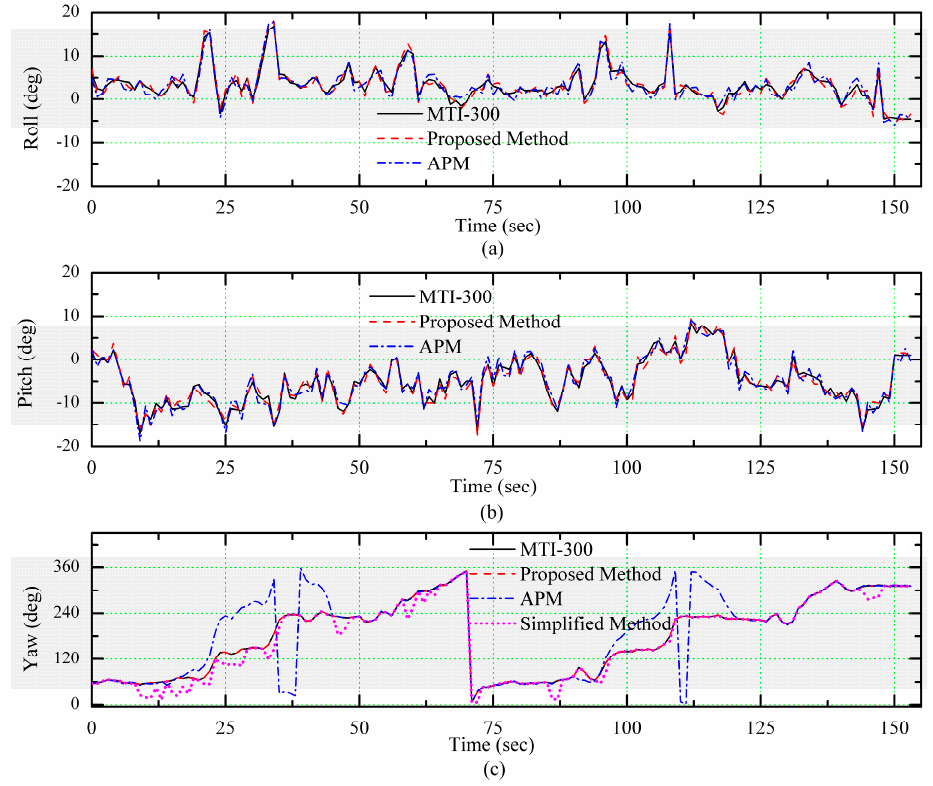
Figure 8. The estimated attitude over time. ( a ) Roll, ( b ) Pitch, ( c ) Yaw.